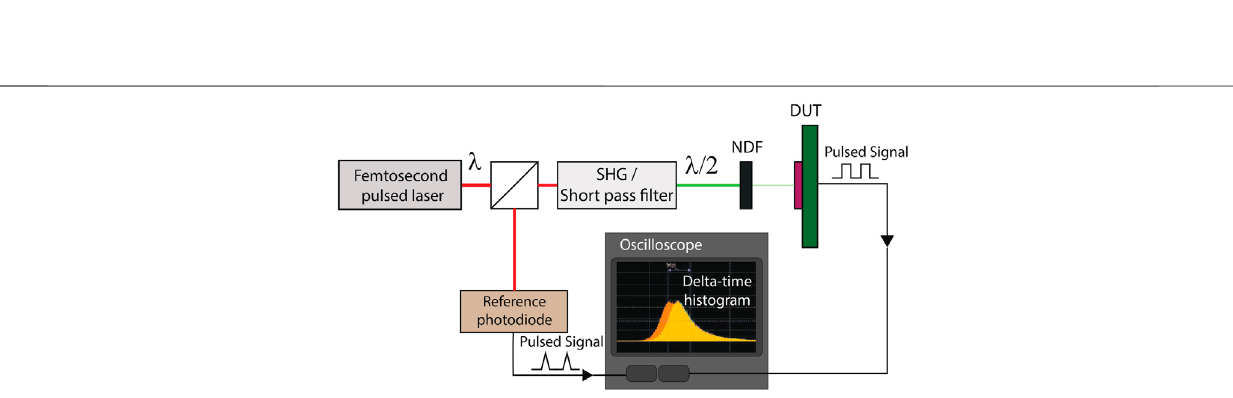
FIGURE 4 | Experimental setup for device characterization using femtosecond pulsed